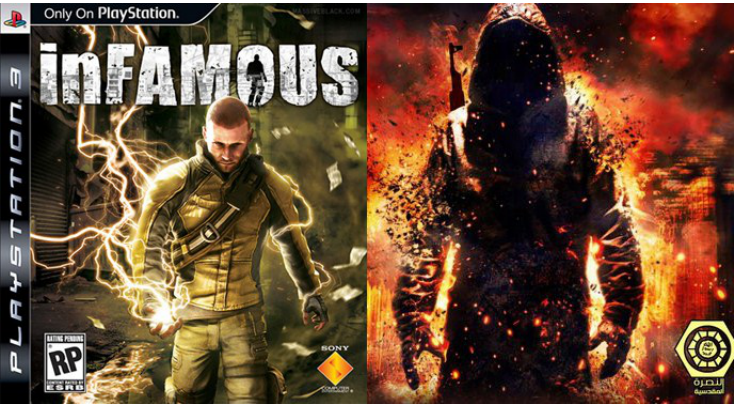
Figure 1. A polished, pre-prepared representation of the Paris attacks by Da’esh, keying into the iconography of video games and the values of the young people who play them. iconography of video games and the values of the young people who play